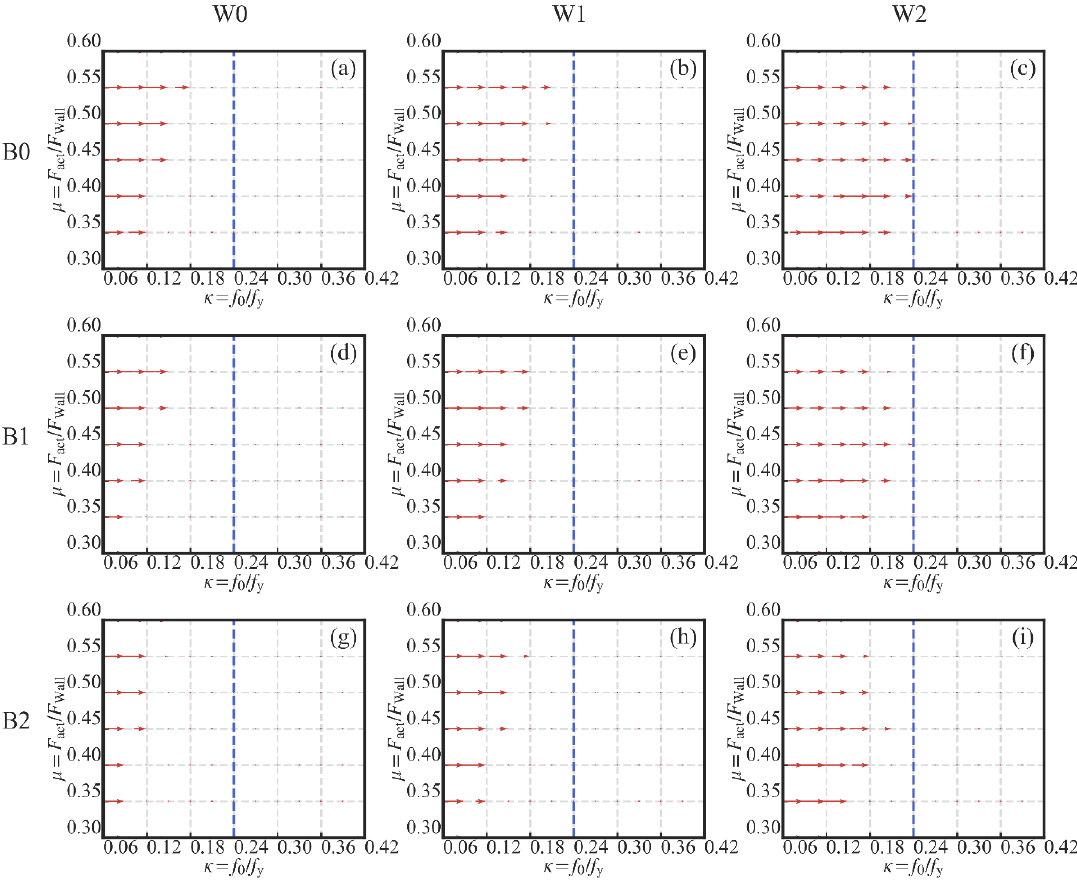
Figure 17. Gradient field (along the direction of the decrease in κ ): ( a ) W0B0; ( b ) W1B0; ( c ) W2B0; ( d ) W0B1; ( e ) W1B1; ( f ) W2B1; ( g ) W0B2; ( h ) W1B2; ( i ) W2B2.